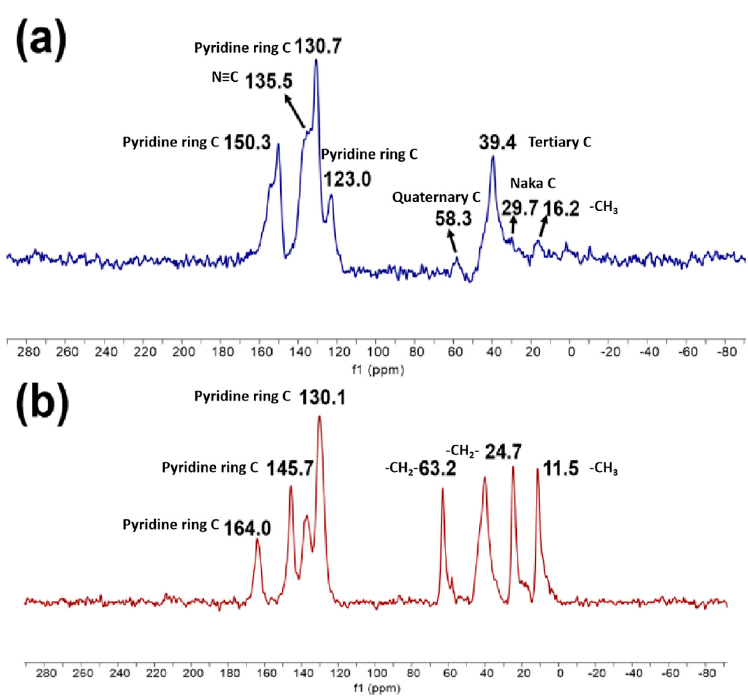
Figure 5. 13 C-NMR spectra of SG-VTS-VP ( a ) and SG-VTS-VPQ ( b ).